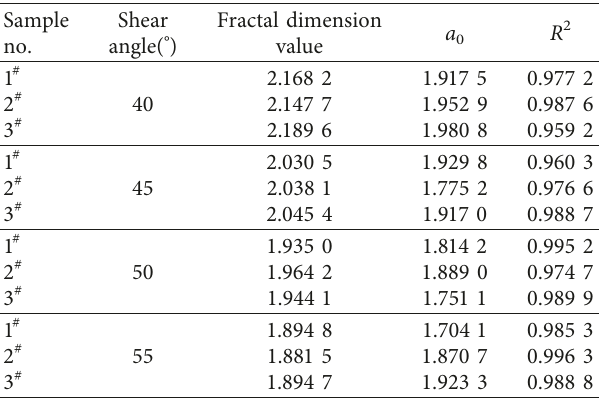
Figure 6: Distribution of compression shear-failure-fractured specimens. (a) 40 ° . (b) 45 ° . (c) 50 ° . (d) 55 ° . Table 2: Distribution of fractal dimension of fractured mudstone blocks under compression and shear load.